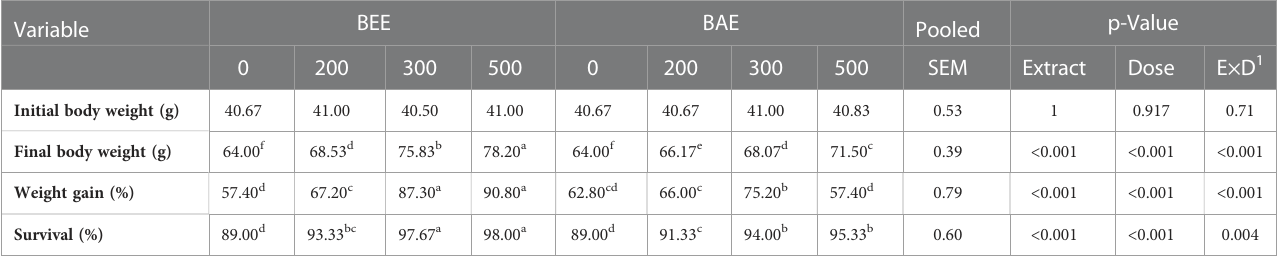
TABLE 2 Effect of dietary supplementation of basil ethanol and aqueous extracts (mg kg -1 of feed) on growth performance and survival of Nile tilapia, Oreochromis niloticus .